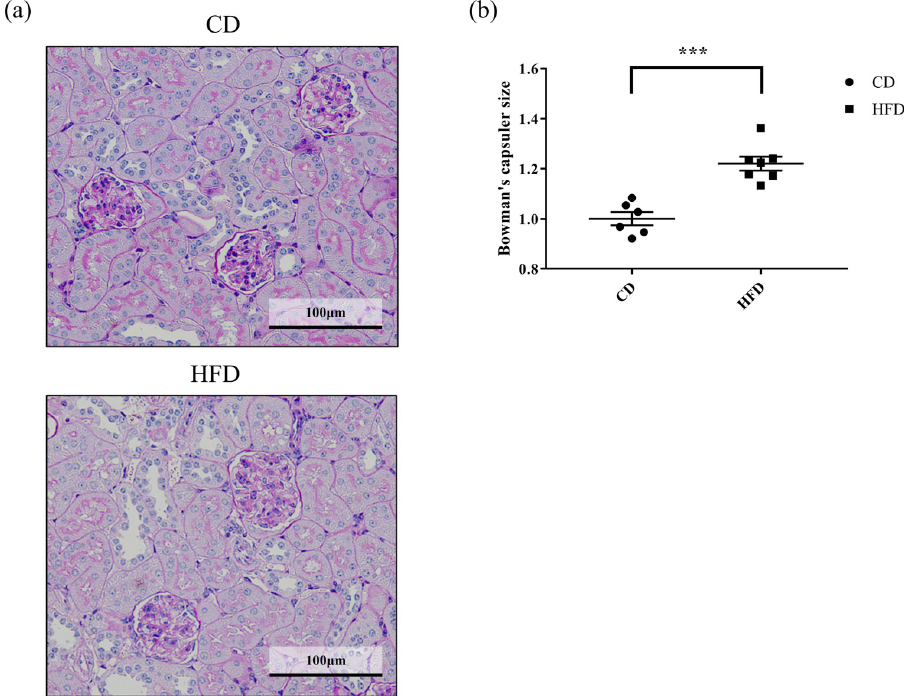
Fig 2. Effect of HFD on lipid deposition in renal tubules. Representative images of periodic acid–Schiff-stained C57BL6/J mouse renal tissue sections. Mice are fed with (a) CD or (b) HFD for 16 weeks. Lipid droplets are observed in the tubular epithelial cells (arrowheads) in renal tissues of HFD-fed mice. The droplets are devoid in the CD-fed mice. (c) Quantification of the fractional area of lipid droplets. Ratio of the total area of lipid droplets to the tubular area is quantified at randomly captured images from the all mice. Bars indicate mean ± SEM. ��� p < 0.001 (unpaired t-test). n = 6 in CD and 7 in HFD, respectively. CD, control diet group; HFD, high-fat diet group.